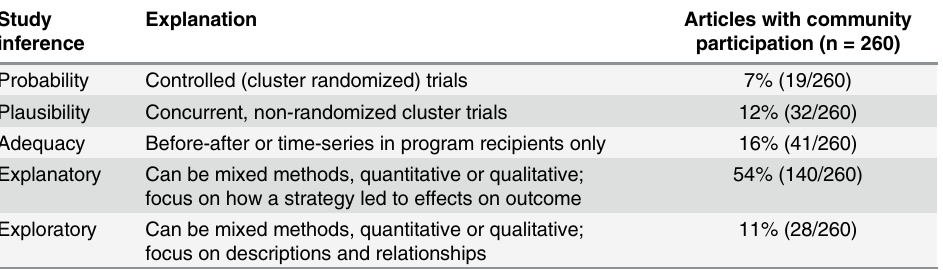
Table 4. Study inference.